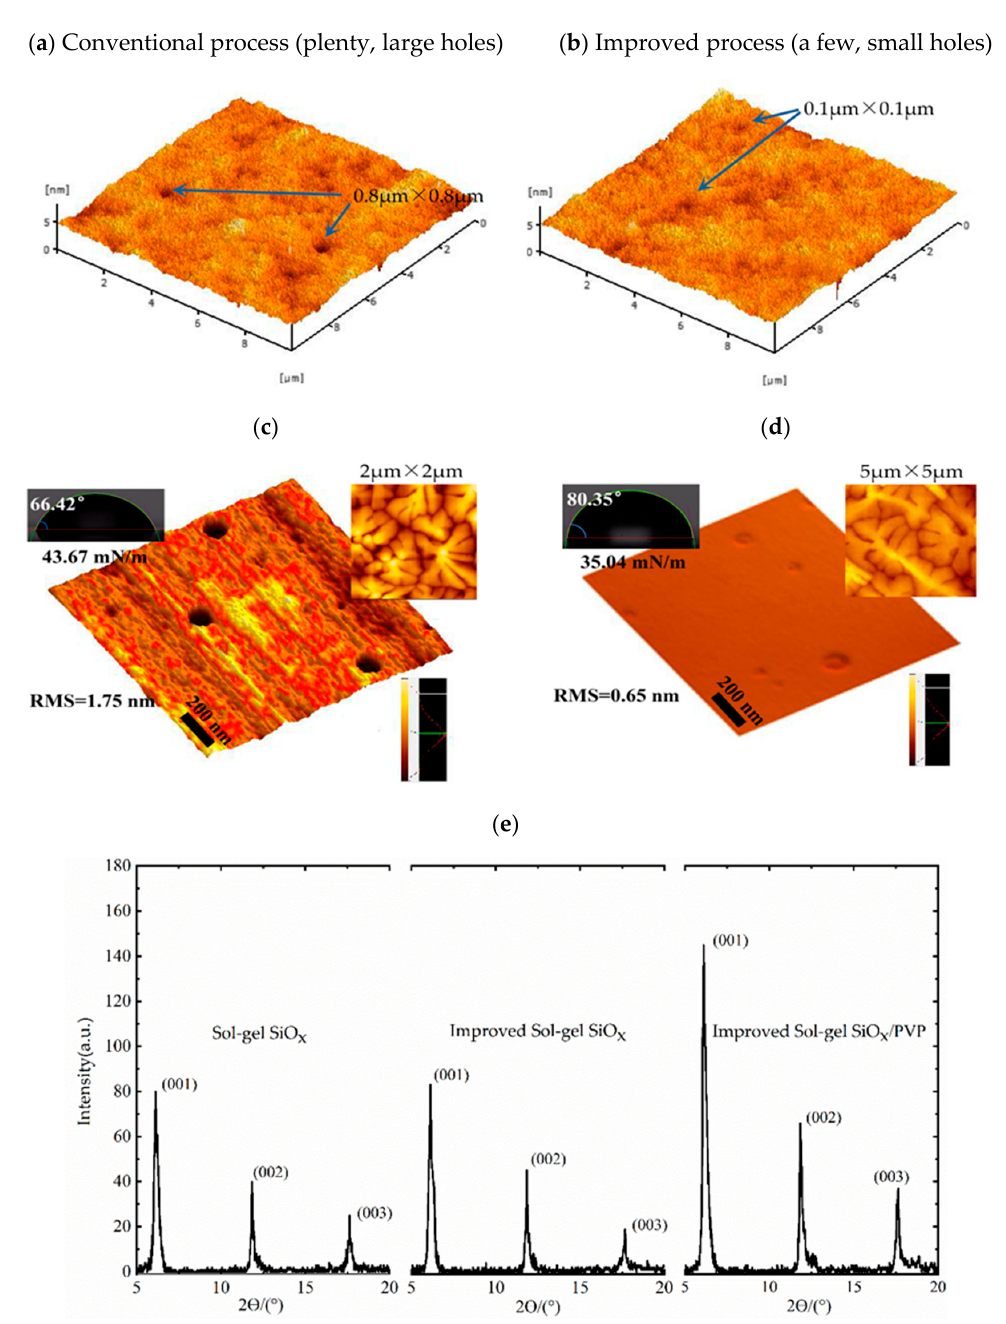
Figure 2. Three-dimensional topography images of ( a ) conventional solution–gelation (sol–gel) SiO x , ( b ) improved sol–gel SiO x , ( c ) upscaled improved sol–gel SiO x film, ( d ) upscaled improved sol–gel SiO x /PVP film. Water contact angle (left), atomic force microscope (AFM) image of pentacene grown on related dielectric(right). ( e ) X-ray diffraction (XRD) patterns of crystal phase structures of pentacene (40 nm) grown on different dielectrics.